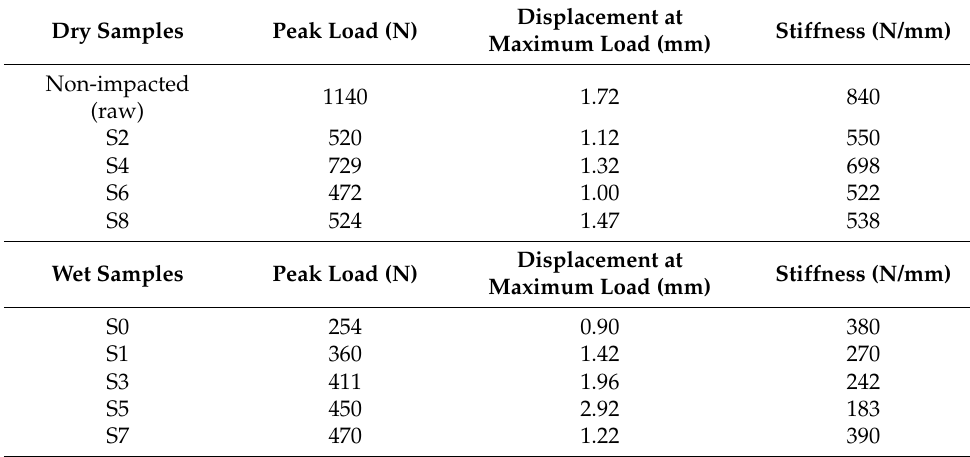
Table 1. Maximum load, displacement at maximum load, and stiffness values for shear samples, in dry and wet conditions, after 900,000 impact